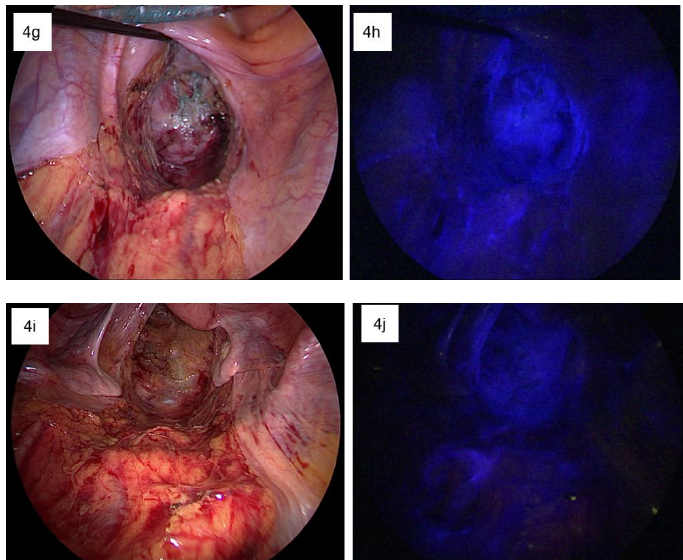
Figure 4. The different patterns of ICG fluorescence signals observed intraoperatively. ( a , c , e , g , i ) The gross appearance of the pelvic floor after the rectal transection in color images of different patients. ( b ) The pure ICG fluorescence image under NIR light indicates the bilateral lymphatic flow. ( d ) The pure ICG fluorescence image under NIR light indicates the lymphatic flow only to the right side. ( f ) The pure ICG fluorescence image under NIR light indicates the lymphatic flow only to the left side. ( h ) The pure ICG fluorescence image under NIR light indicates the lymphatic flow to the bilateral pelvic side wall as well as to the presacral area up to the bifurcation of the common iliac vessels. ( j ) The pure ICG fluorescence image under NIR light indicates the lymphatic flow only to the presacral area up to the bifurcation of the common iliac vessels. Table 1. Patient demographics, clinicopathology, and ICG fluorescent detection